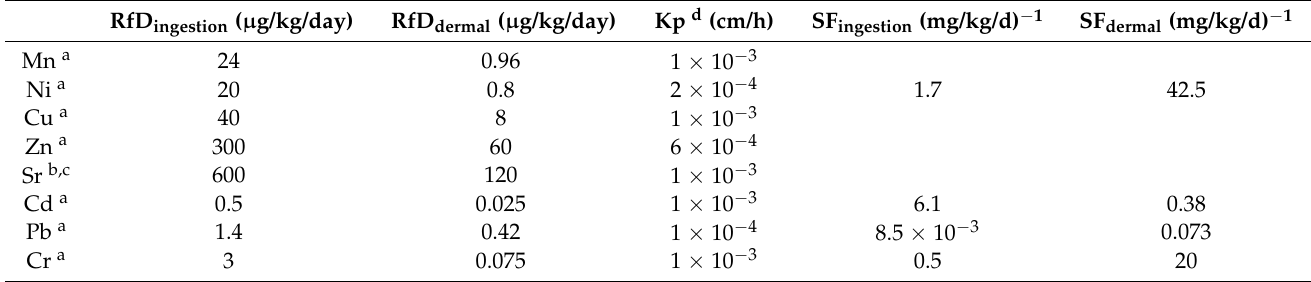
Table 2. Standard values of RfD, Kp, and SF in the study.